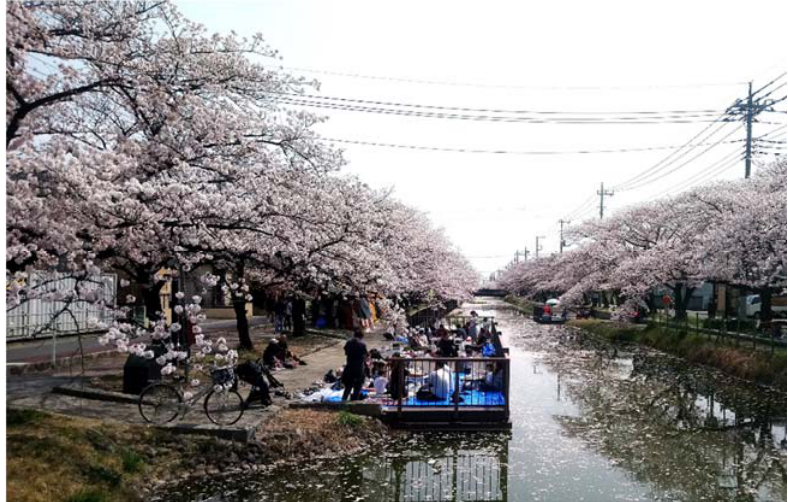
Figure 5. The cherry blossom festival along the Kasai Canal in Soka, Saitama Prefecture. Several hundred cherry trees are planted along the canal; people enjoy their time among the blossoms. This canal is the site where established Aromia bungii was first detected in southern Saitama in 2013.